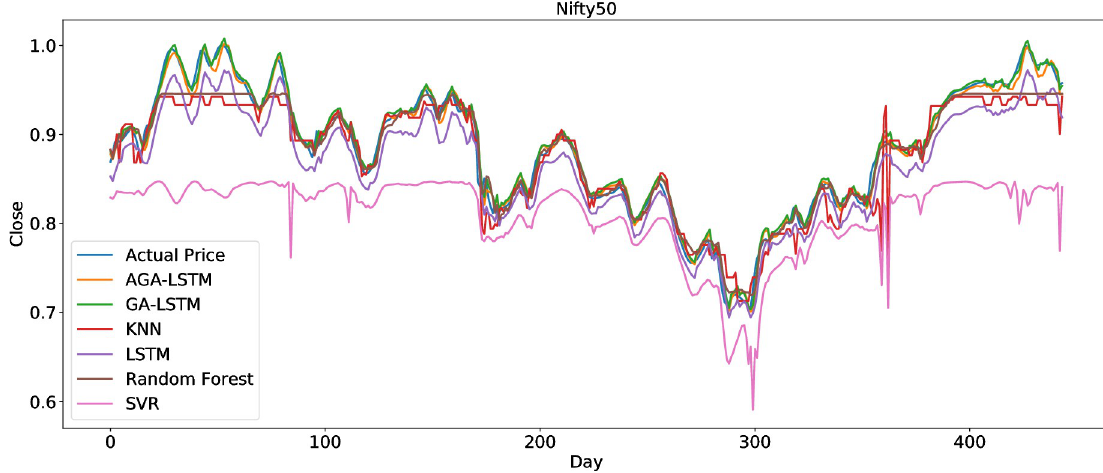
Fig 23. Comparison of AGA-LSTM and other DL models in Nifty50 data set.